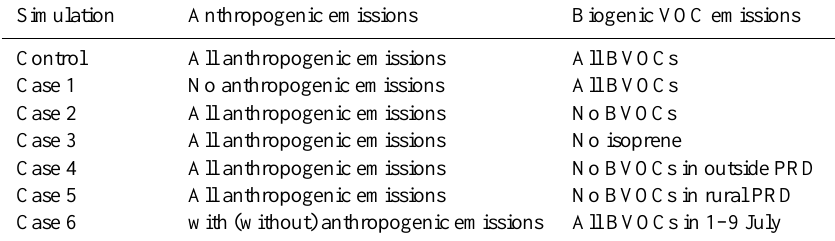
Table 3. Description of model simulations. Simulation Anthropogenic